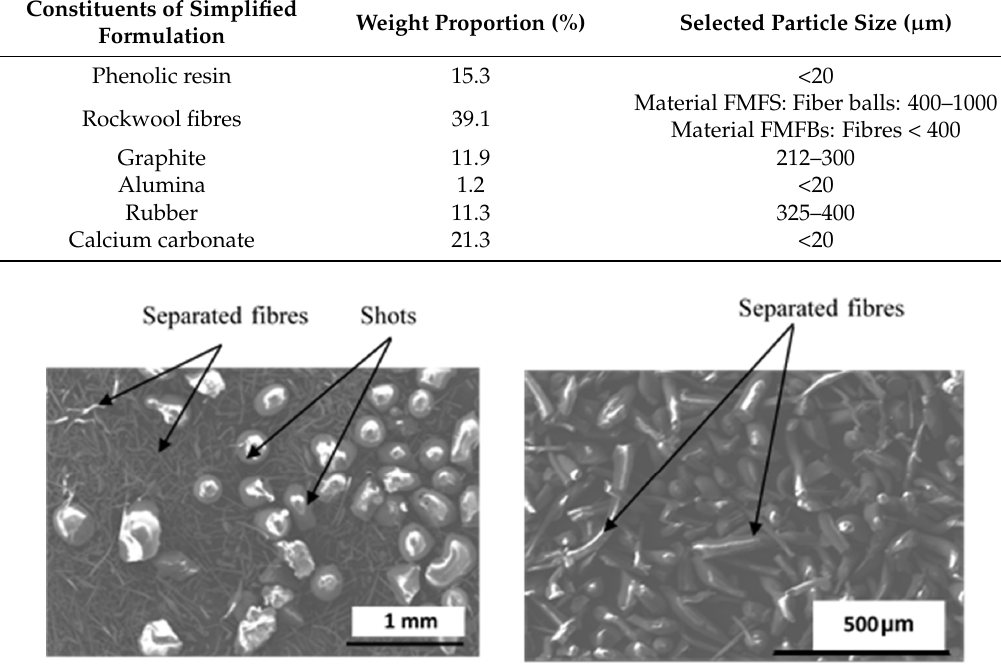
Figure 1. Morphologies of rockwool fibres (SEM-SE).